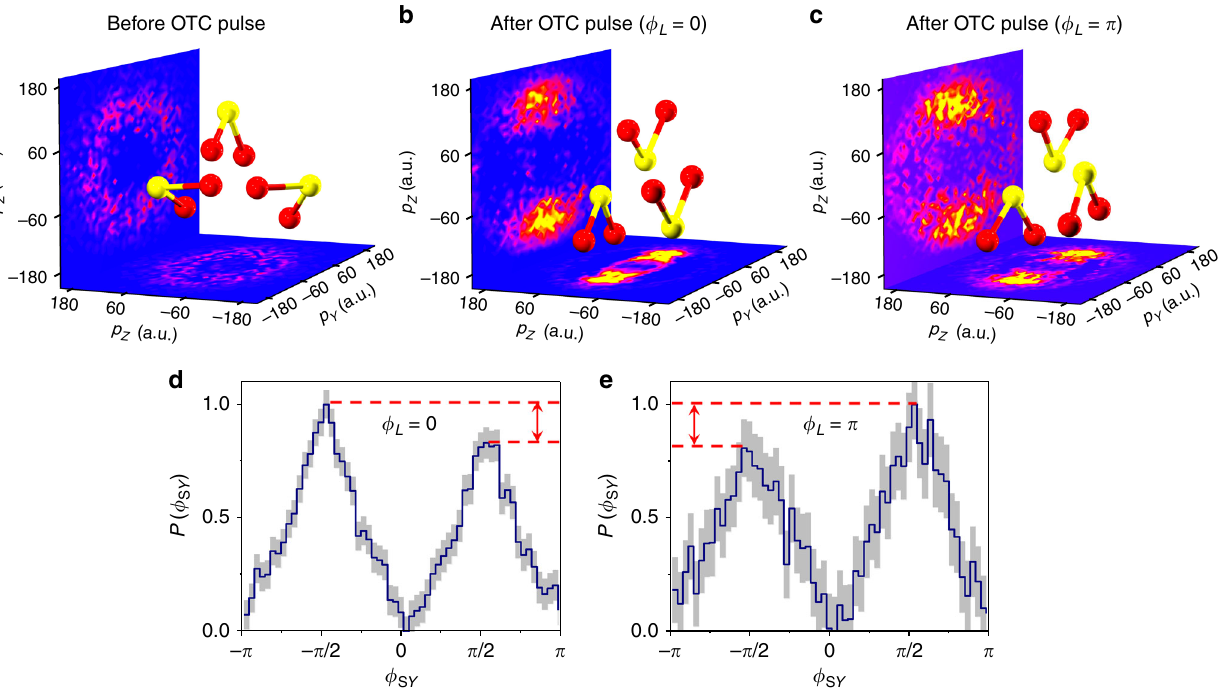
Fig. 4 Coincidentally measured momentum distributions of S + and O + . Here p Y and p Z are the projections of fragments ’ momenta on Y and Z axes, respectively (measured in atomic units). a Isotropic momentum distribution for S + and O + ions measured before the arrival of OTC pulse. b and c Anisotropic momentum distributions for S + and O + ions measured at t ≈ 0.20 ps after the application of the OTC pulse at ϕ L = 0 and π , respectively. d and e Angular distributions of ϕ S Y derived from b and c , respectively. Gray bars represent the uncertainty propagated during data analysis according to Gaussian ’ s propagation